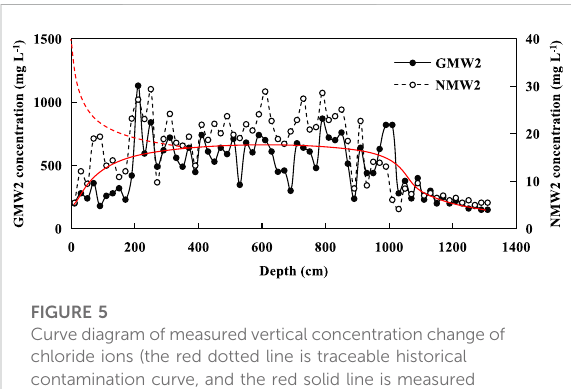
FIGURE 6 Relationship between maximum vertical migration depth ( z tj ) and measured values of chloride ions under different detection criteria. ( △ ) and ( ◇ ) represent the measured chloride ions depth of GMW2 and NMW2, respectively; The black solid line represents z tj under different detection